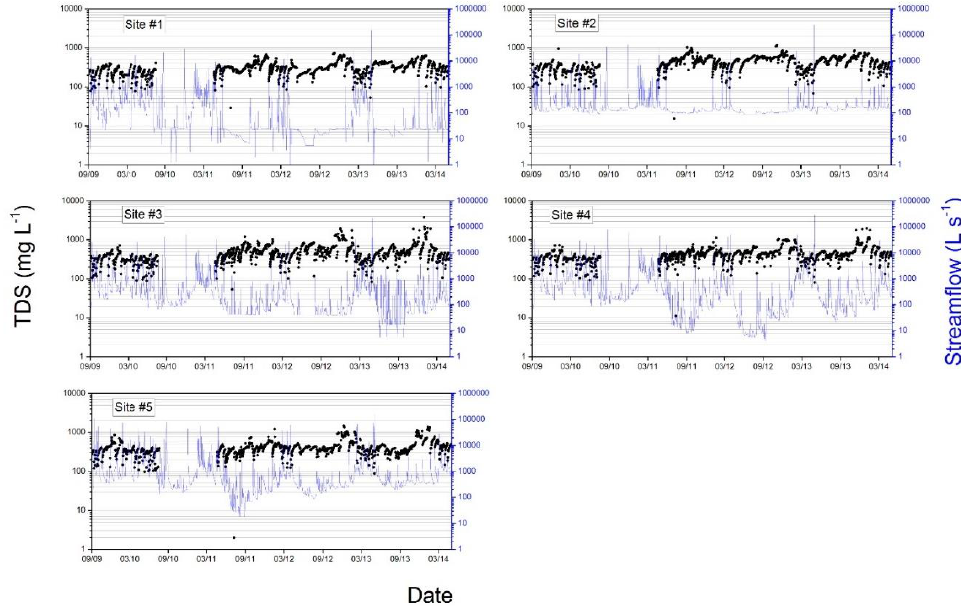
Figure 4. Total dissolved solids (TDS) (mg L −1 ) and streamflow (L s −1 ) at each gauging site ( n = 5) during study period (October 2010–May 2014) in Hinkson Creek Watershed, MO, USA.